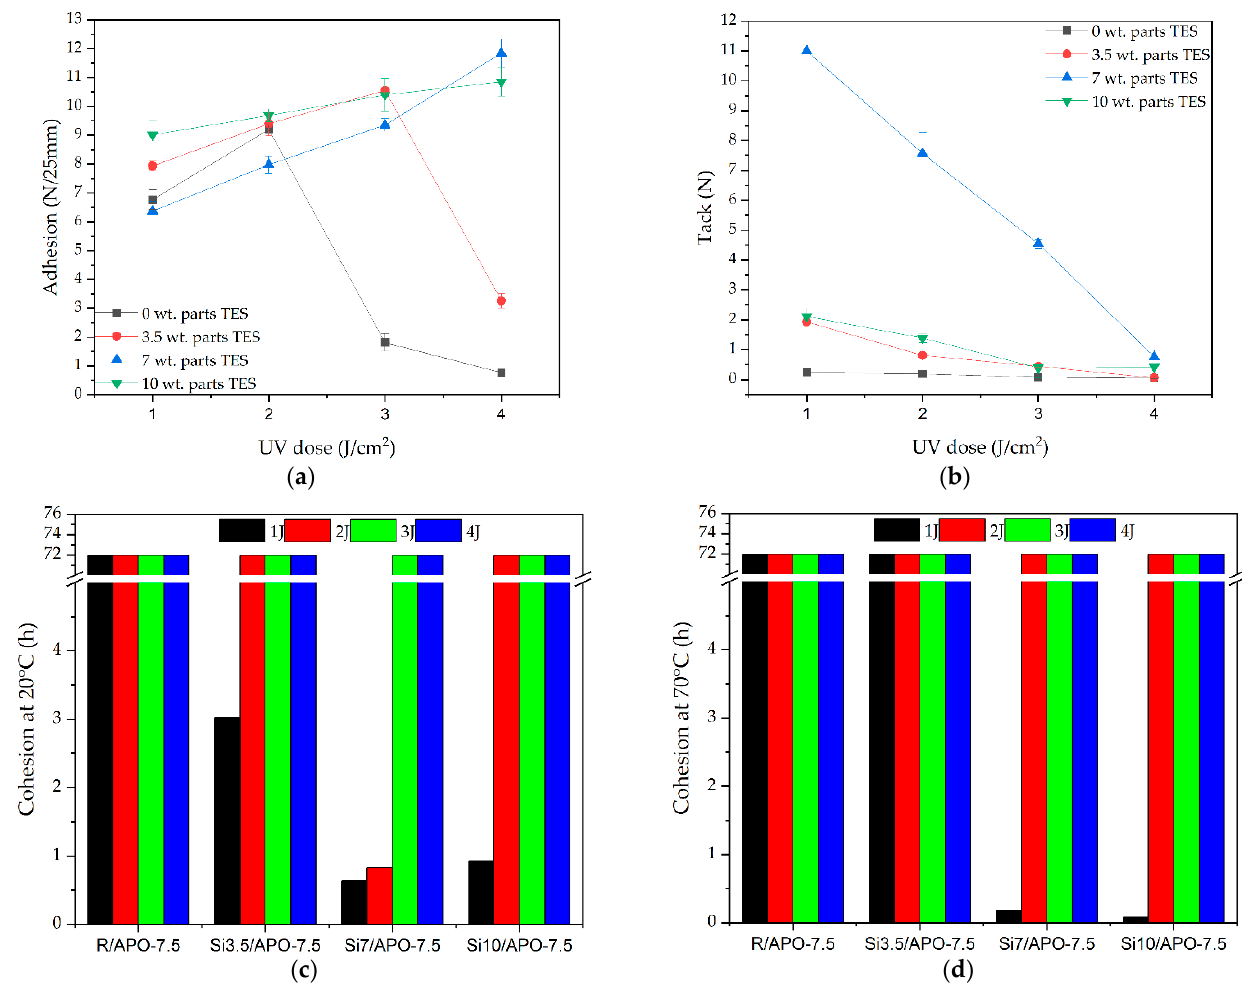
Figure 7. Self-adhesive properties of PSAs based on Si telomere syrups with the same amounts of APO (0.075 wt. parts): ( a ) adhesion to steel, ( b ) tack, and ( c ) cohesion at 20 °C and (d) 70 °C.